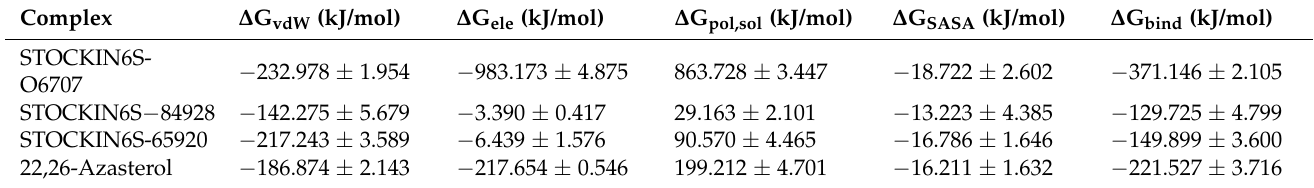
Table 5. Contributions of van der Waal, electrostatic, polar solvation, and solvent-accessible surface area energies to the binding free energy of the protein–ligand